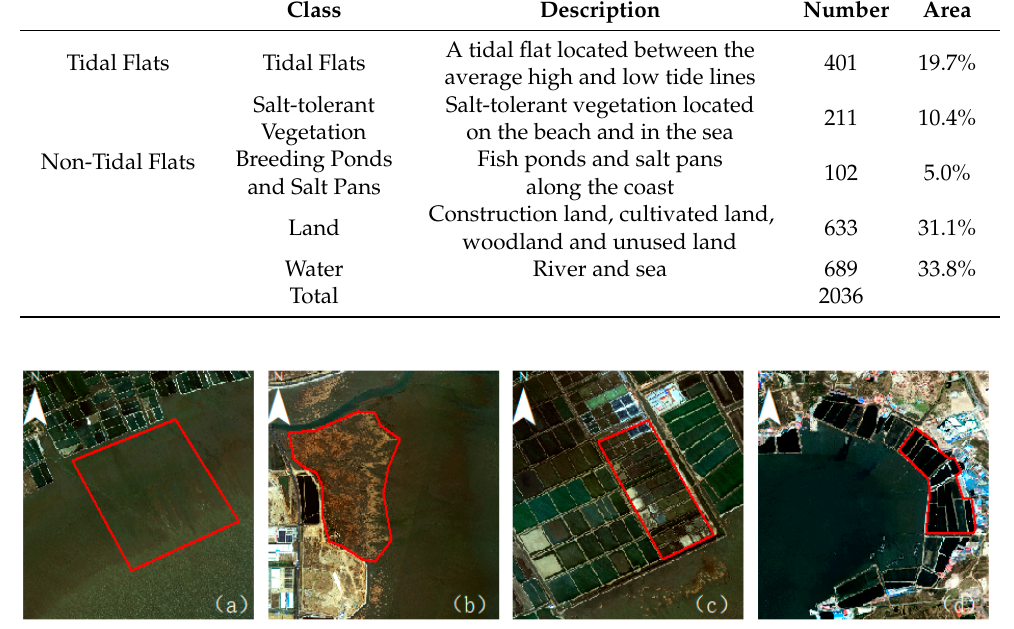
Figure 6. Interpreted areas on high-resolution remote sensing image (GF-2). ( a ) Tidal flat; ( b ) salt-tolerant vegetation; ( c ) salt pan; ( d ) breeding pond.